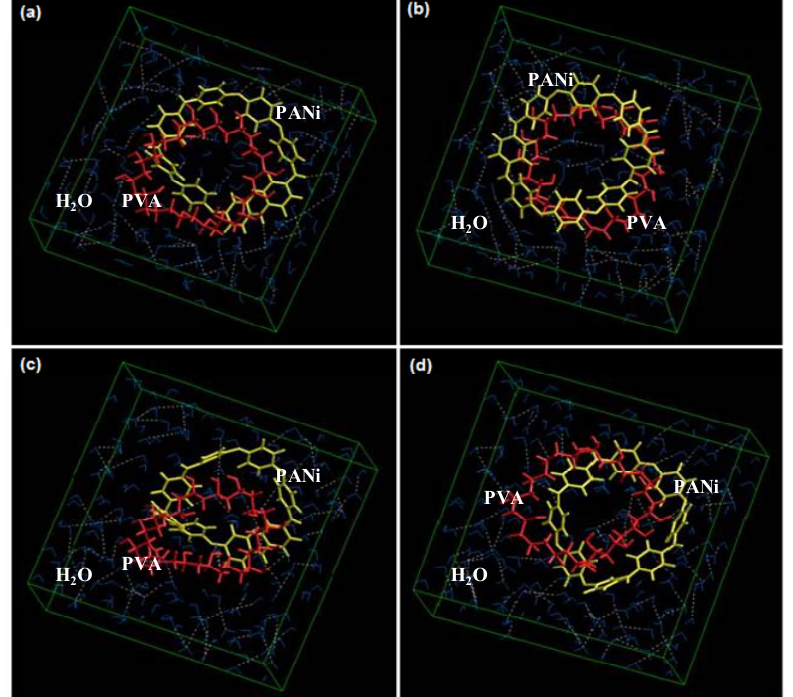
Figure 9. Visualization of geometrical preferences of the PVA-PANi molecule after molecular simulation in a solvated system under an external electric field: ( a ) No external field, ( b ) 0.01 a.u, ( c ) 0.02 a.u, ( d ) 0.03 a.u, ( e ) 0.04 a.u and ( f ) 0.05